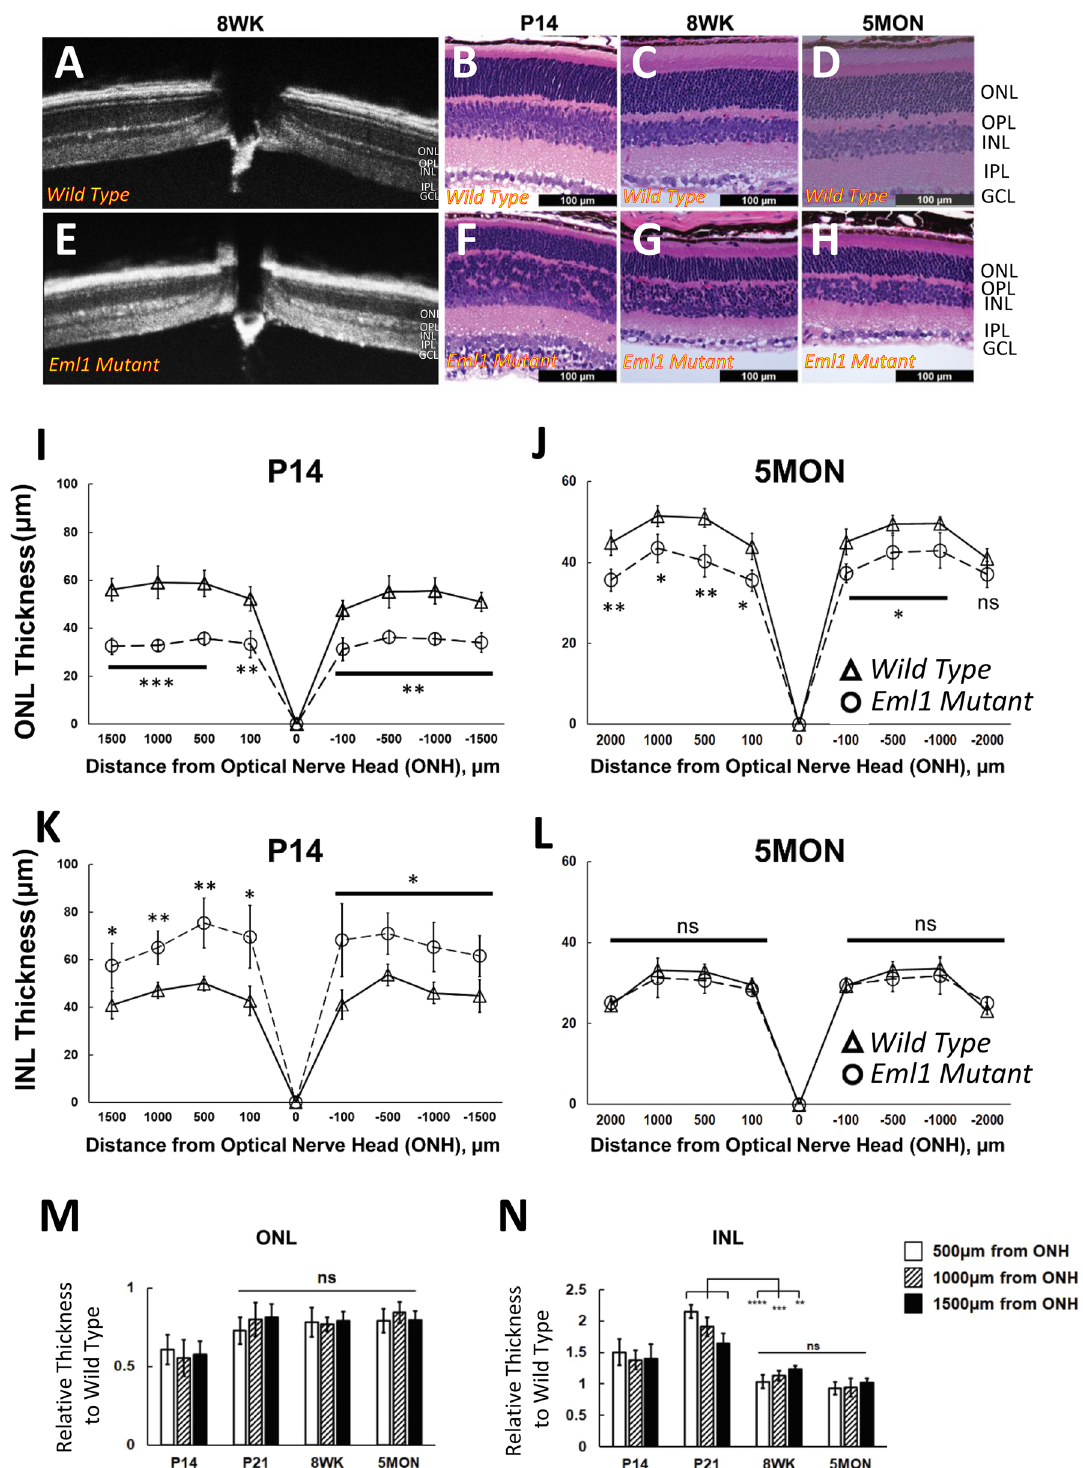
Figure 7. Morphology of Eml1 mutant retinas. ( A , E ) Comparison of 8 weeks-old wild type and age matched Eml1 mutant OCT screening respectively. H&E staining from wild type retina at P14 , 8 weeks and 5 months of age ( B – D respectively) and age-matched Eml1 mutant retina ( F – H respectively) . The quantification of ONL thickness as a function of the distance from the optic nerve head shown as spider plots in wild type retinas ( triangles ) and Eml1 mutant retinas ( circles ) at P14 ( I ) and at 5 months ( J ). The quantification of INL thickness as a function of the distance from the optic nerve head shown as spider plots in wild type retinas ( triangles ) and Eml1 mutant retinas ( circles ) at P14 ( K ) and at 5 months ( L ). The temporal pattern of relative ONL ( M ) and INL ( N ) thickness measured at 500, 1000 and 1500 μm from the optic nerve head (ONH) at P14, P21, 8 weeks and 5 months in Eml1 mutants . Error bars show S.D. for all